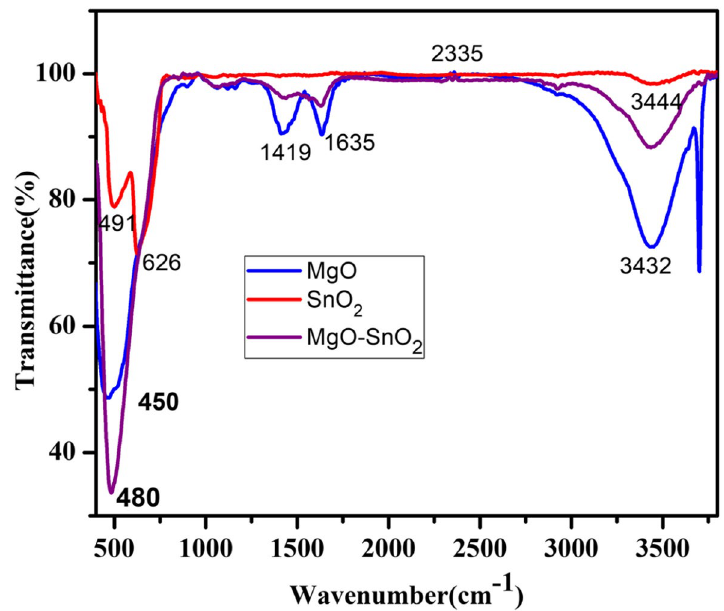
Fig. 4 Comparison of FTIR spectra of MgO, SnO 2 , and MgO-SnO